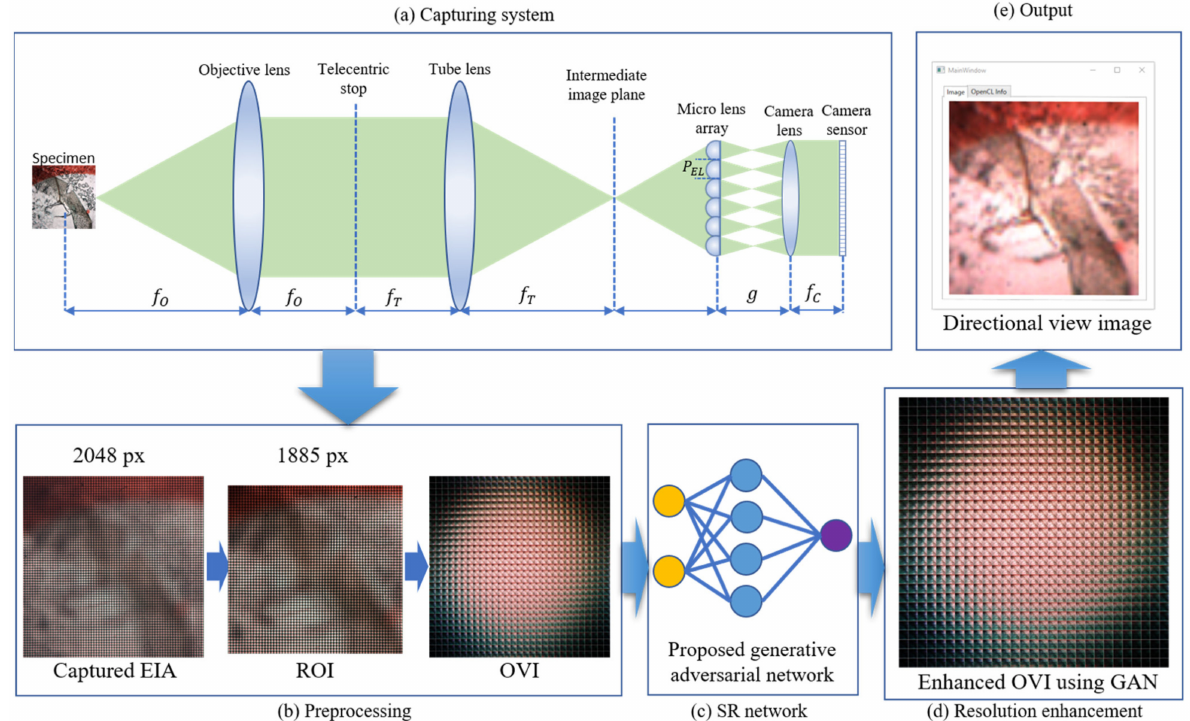
Figure 4. Block diagram of the proposed IIM resolution enhancement method. ( a ) An IIM capturing system where objective lens, tube lens, and micro lens array is employed to capture the EIA. ( b ) In the preprocessing part, the outer dark part is removed by cropping the elemental image array (EIA), and orthographic view image (OVI) is generated from the EIA using the pixel mapping algorithm. ( c ) A super-resolution algorithm is designed and trained using generative adversarial network (GAN). ( d ) The resolution of the OVI is enhanced using the SR network. ( e ) The resolution-enhanced directional view image is shown as an